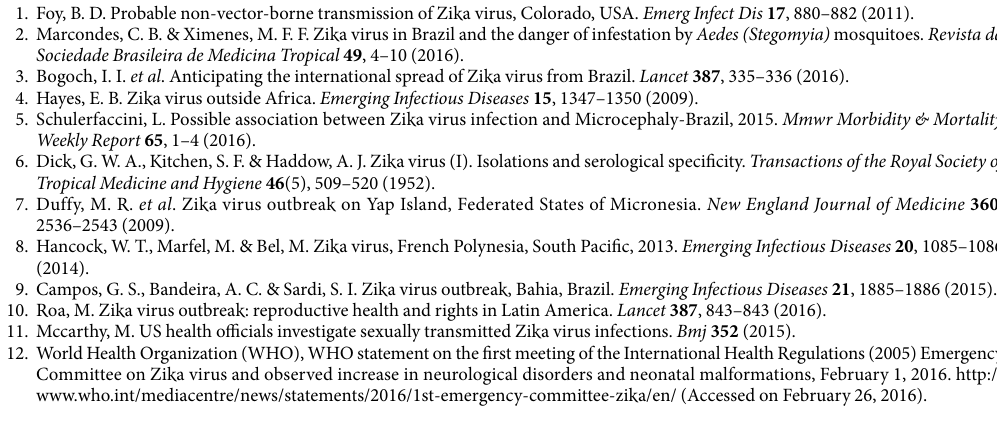
12 Scientific REPORTS | 7: 7721 | DOI:10.1038/s41598-017-07264-y